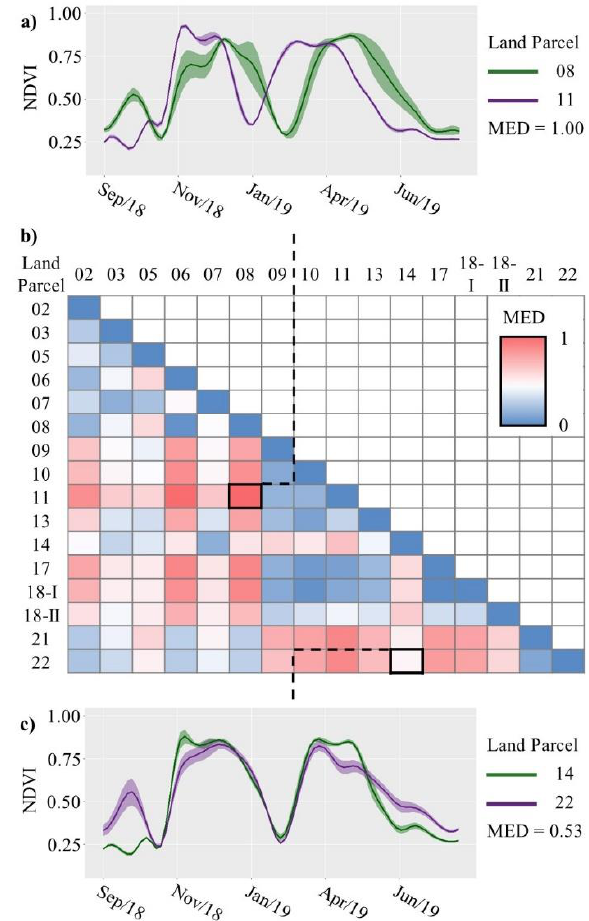
Figure 2 . Exploratory analysis of the double crop land parcels' and their paired comparison of NDVI temporal signatures. b) Matrix of distance-based variability among land parcels, illustrating a) the lowest NDVI temporal signature variability between parcels 08 e 11, and (c) a moderate variability between parcels 14 and